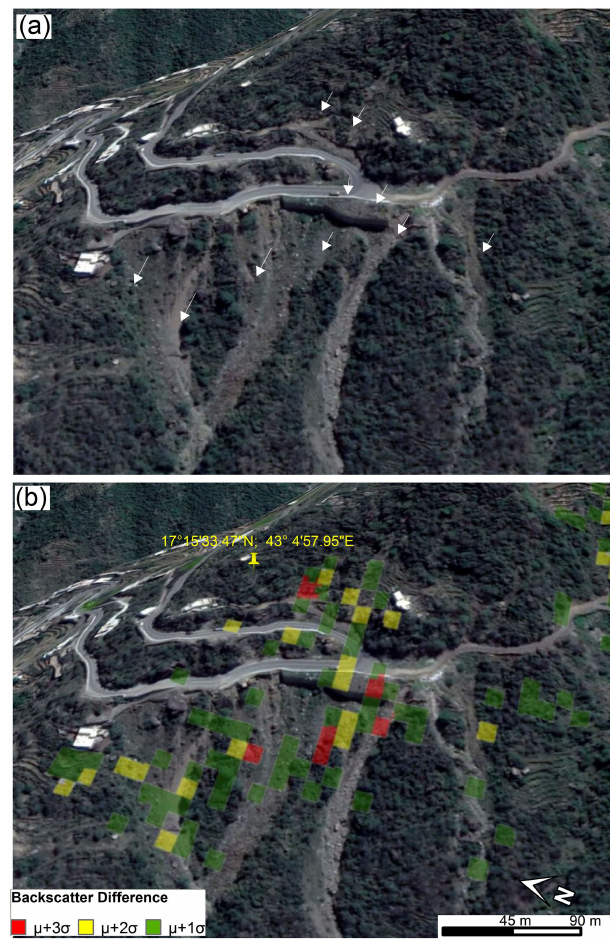
Figure 7. (a) Google Earth imagery (map data: Google, Digital- Globe, and CNES/Airbus) showing the distribution of debris flows (identified by white arrows). (b) Backscatter difference image for two descending scenes bracketing (acquisition dates: 24 Decem- ber 2015 and 10 February 2016) a precipitation event on 25 De- cember 2015 showing correspondence of areas of low to negligible variations ( ≤ 1 SD) with vegetation and areas exceeding 1 SD (clus- ters of red, yellow, and green pixels) to debris flow locations that showed evidence for recent redistribution of boulders and cobbles in the